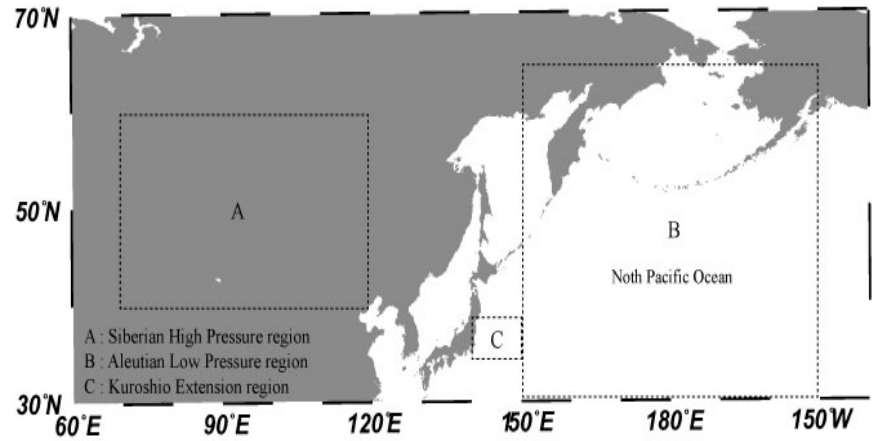
Figure 2. Sea level pressure regions: (A) Siberian high pressure, (B) Aleutian low pressure, and (C) Kuroshio extension region.